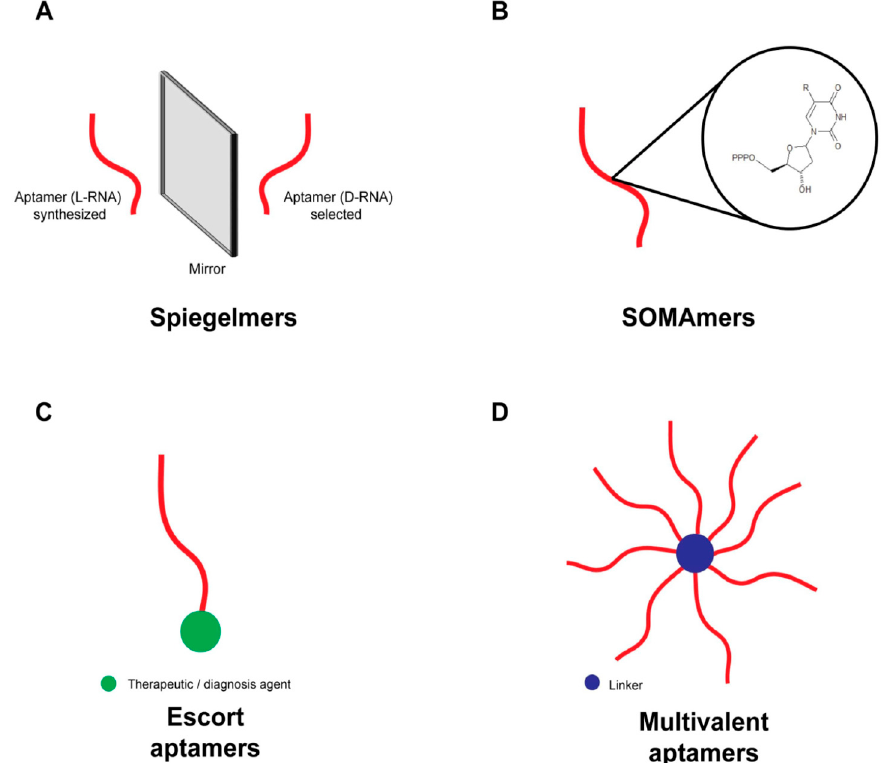
Figure 2. Design of aptamers with the aim to improve function, stability, activity, and/or affinity. ( A ) Spiegelmers. Characterized by the presence of L-ribonucleotides on the RNA sequence to improve stability in biological medium. ( B ) SOMAmers. Sequence containing uridine modified on 5 ′ -position (R) to increase affinity, specificity and stability. ( C ) Escort aptamer. Aptamer linked with a therapeutic